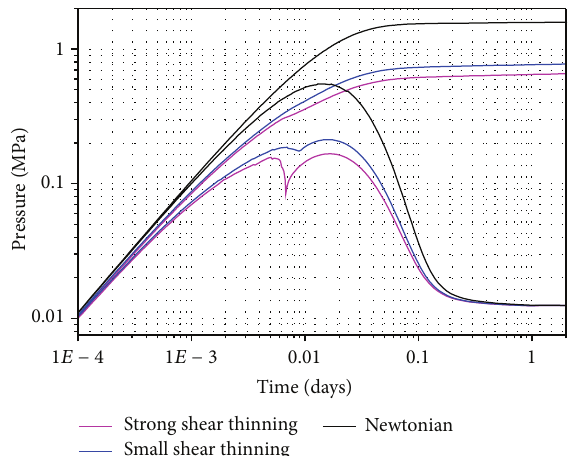
(days)0.01 0.1 Time